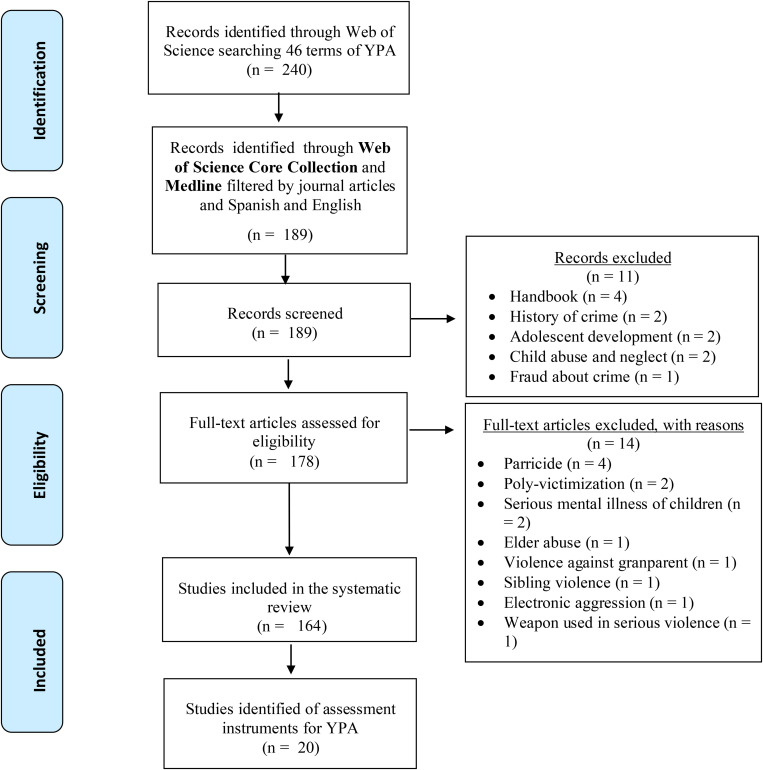
Flowchart of the review process according to Preferred Reporting Items for Systematic reviews and Meta-Analyses (Moher et al., 2009).